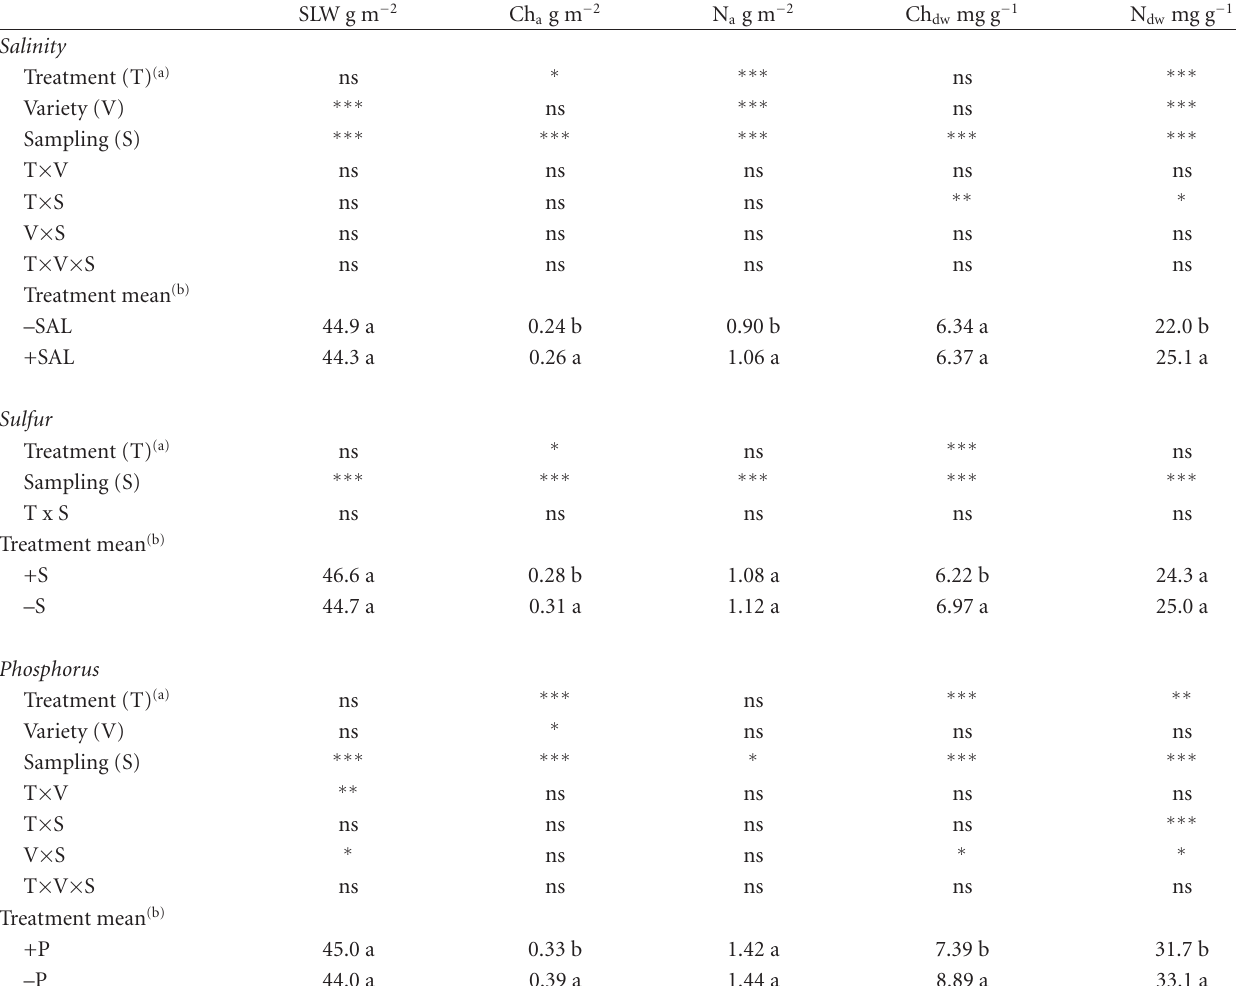
Table 4: Analysis of variance for specific leaf weight (SLW), chlorophyll concentration, and leaf N concentration (Ch a and N a : area based; Ch dw and N dw : dry weight based). The analysis was conducted separately for salinity ( ± SAL), sulfur ( ± S), and phosphorus ( ± P) treatments. Included are mean treatment values across varieties and sampling dates, separated for each stress